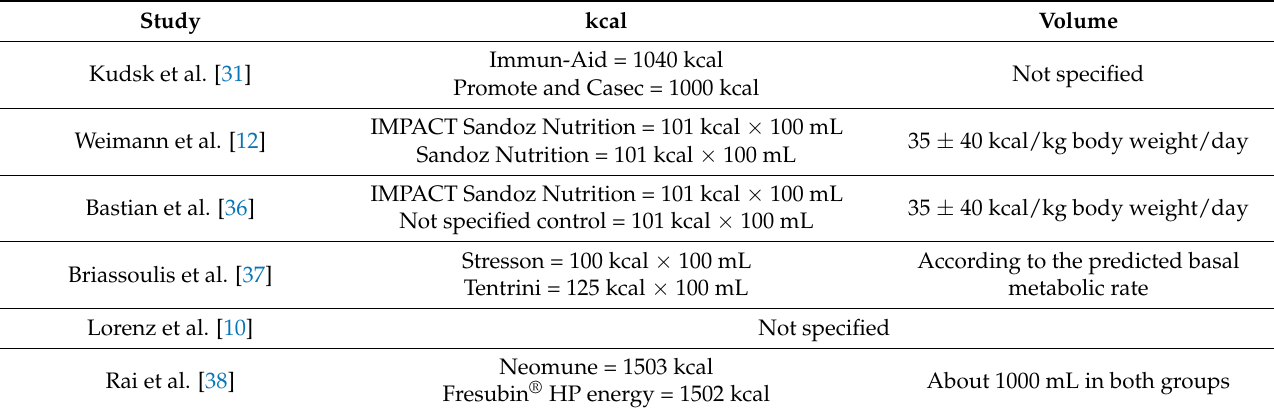
Table 4. Immunonutrition formula kilocalories and volume